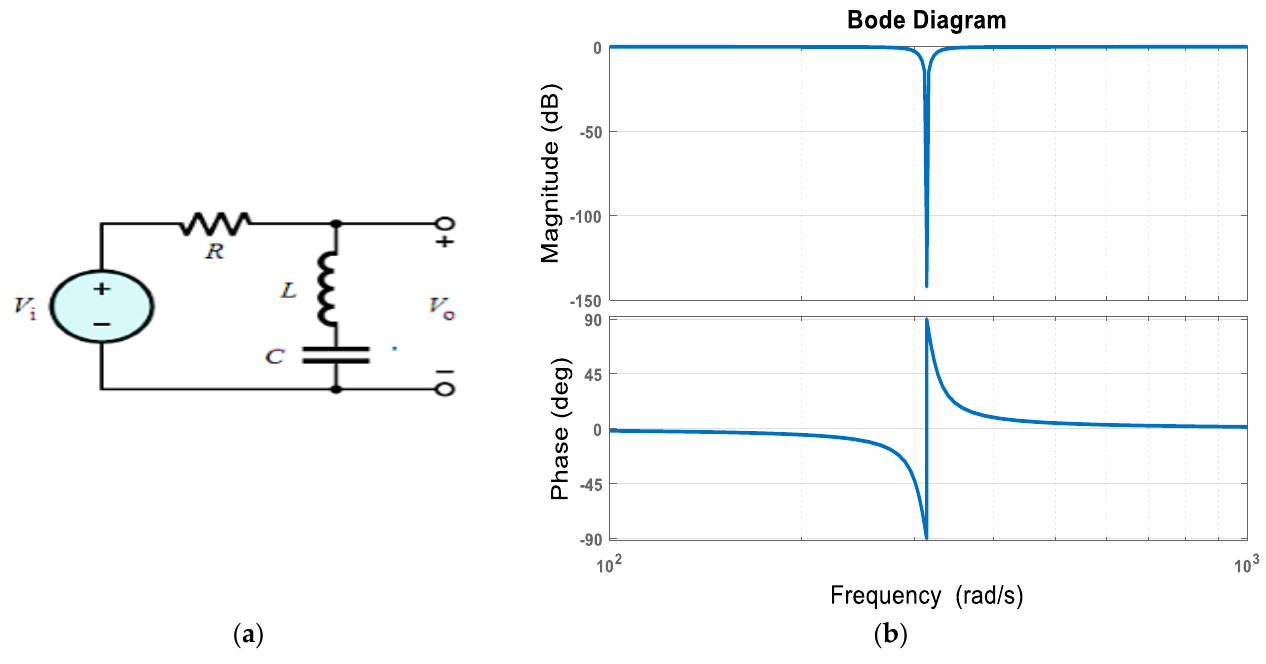
Figure 2. Notch filter of passive element ( a ) equivalent circuit; ( b ) frequency response.